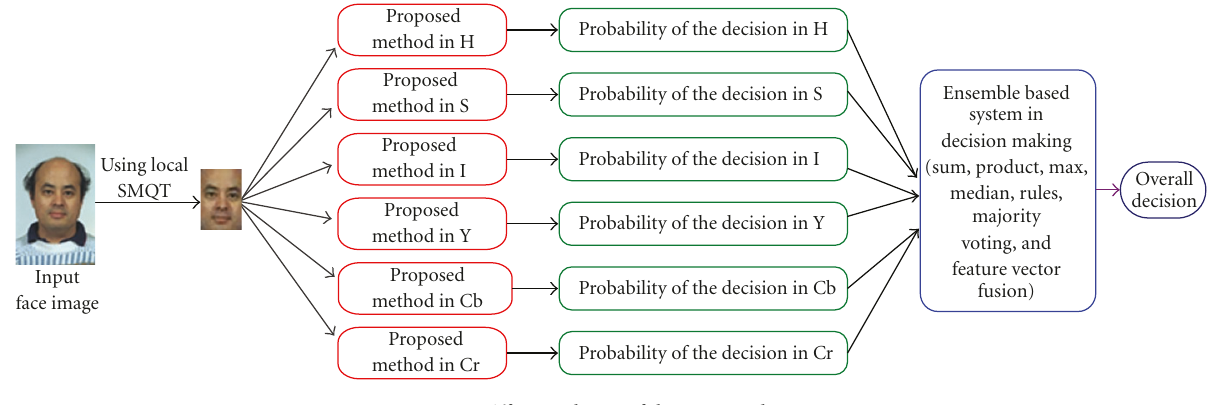
Figure 1: Di ff erent phases of the proposed system.